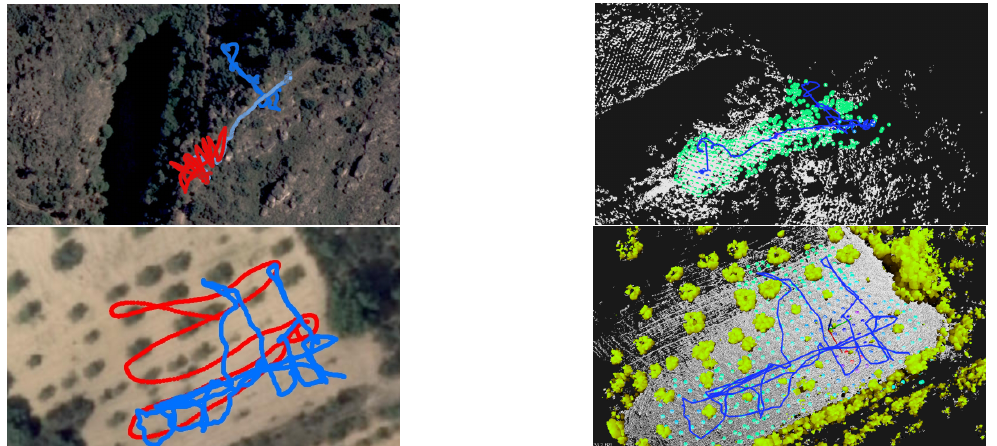
Figure 24. Monitoring flight in Scenario B and C. ( left ) Map of flight in blue, (scouting drone path in red). ( right ) 3D scenario with path and estimation of surface sources are presented by